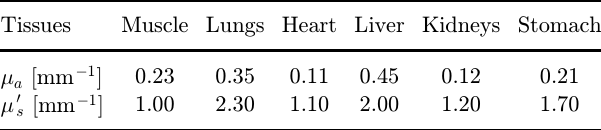
Table 1. Optical parameters for the mouse